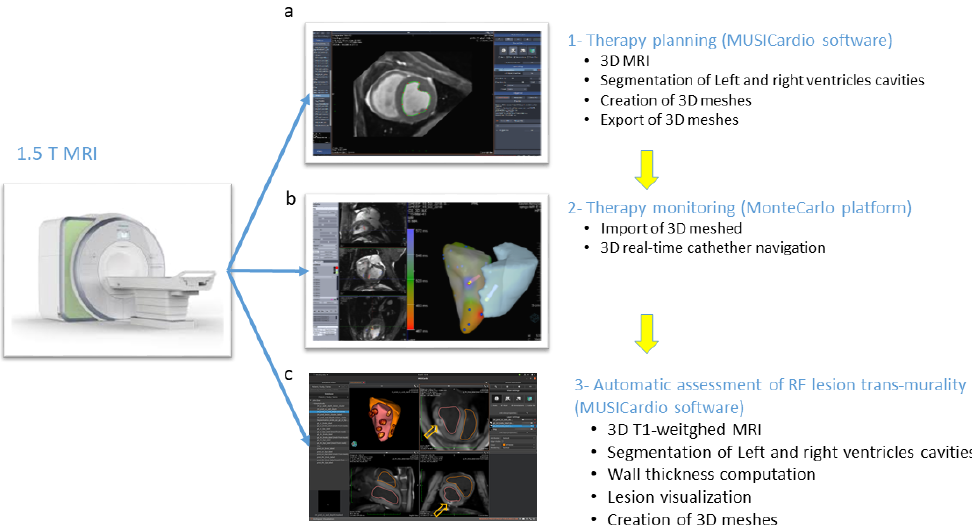
Figure 13. Example of preclinical RF ablation procedure performed under MRI. Three-dimensional (3D) balanced SSFP sequence acquired at the beginning of the session was processed within MUSI- Cardio ( a ) to segment the cavities of the RV and LV. The resulting 3D meshes were then exported to the Montecarlo platform ( b ), allowing real-time 3D catheter navigation and visualisation. After completion of the procedure, 3D T1-weighted images were acquired and processed in MUSICardio ( c ) to automatically compute the transmurality map for each location of RF delivery. Orange arrows show RF lesions with a central thermal necrosis in the hyposignal surrounded by a hypersignal corresponding to